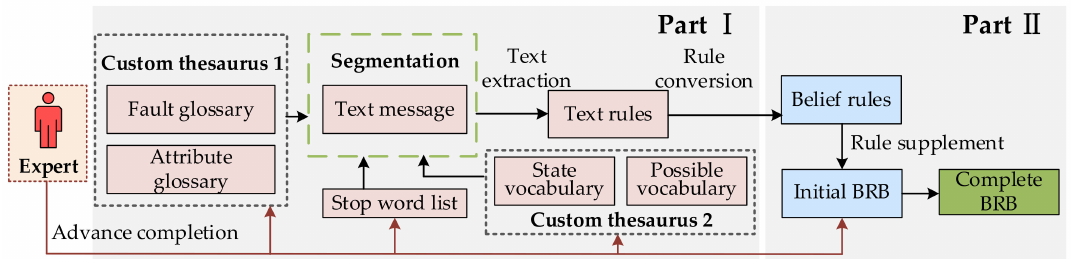
Figure 2. Framework of